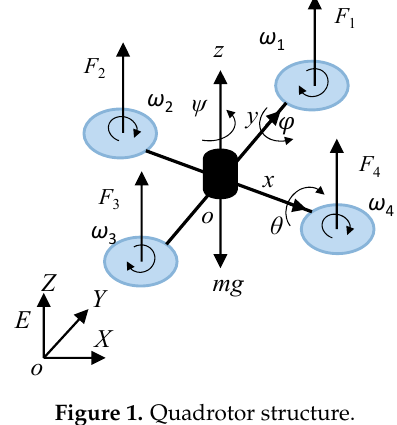
Figure 1. Quadrotor structure.